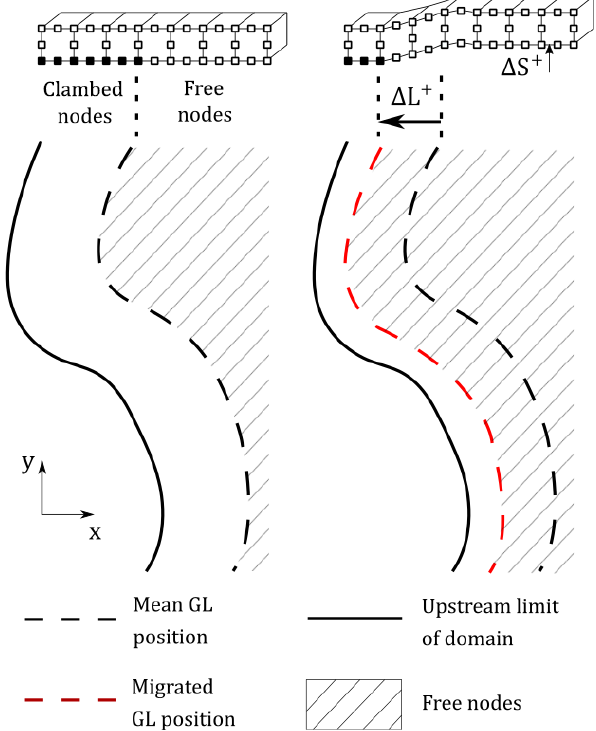
Figure E1. Plan view of a grounding zone, showing how grounding line motion is imposed in the model. Initially the model runs with no tides until it has visco-elastically relaxed. Nodes upstream of the grounding line are clamped at the base and nodes downstream have no constraints. Once tides are switched on, the grounding line can migrate upstream ( (cid:49)L + ) or downstream ( (cid:49)L − ) and nodes that are outside of the defined grounded area have any constraints